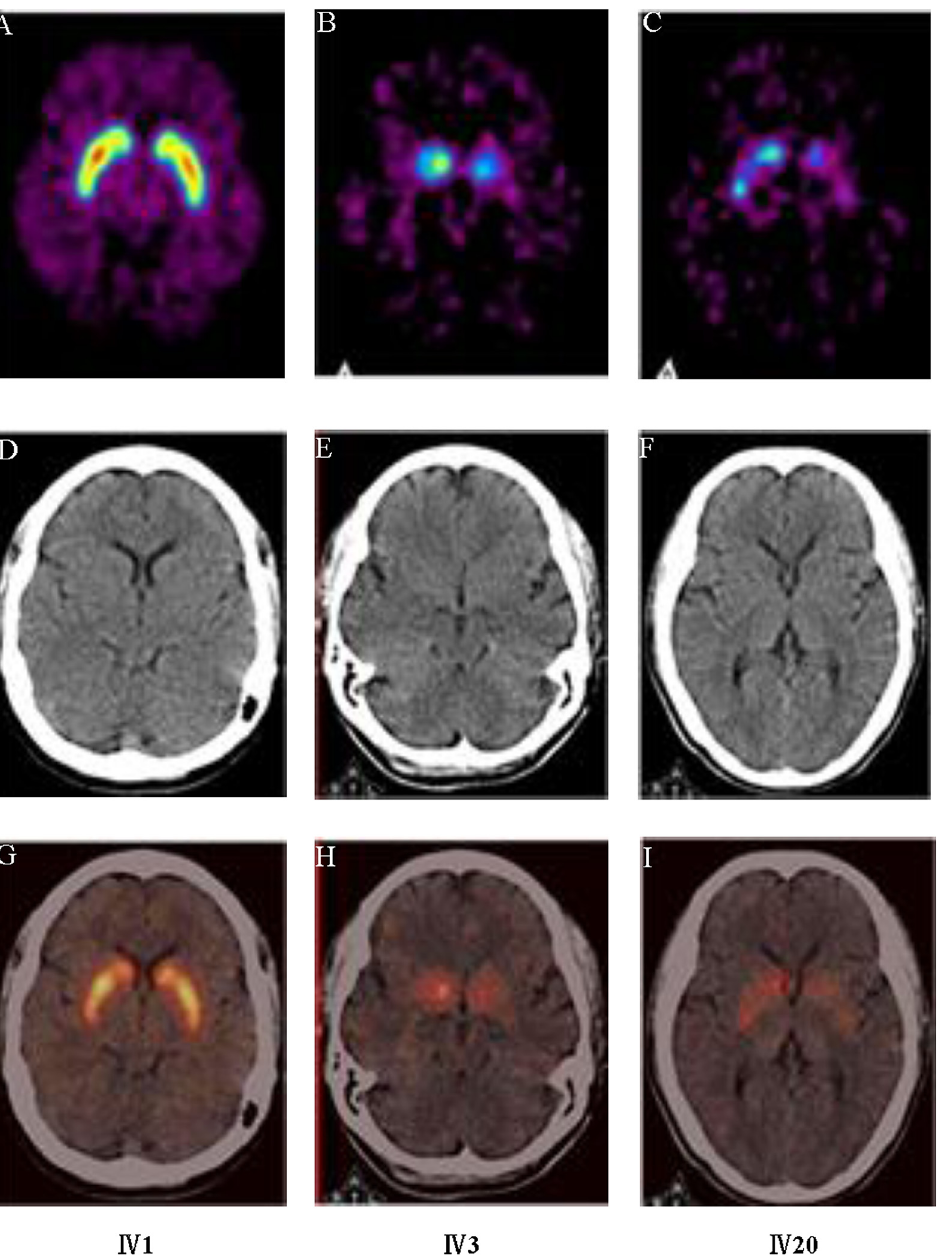
Fig 3. PET imaging of DATs via 11 C-CFT in pedigree with p.N279K MAPT mutation. A-C: Axial positron emission tomographic images of 11 C-CFT uptake in three family members, A, Ⅳ -1, B, Ⅳ -3, C, Ⅳ -20; D-F: The transverse CT in three family members, D, Ⅳ -1, E, Ⅳ -3, F, Ⅳ -20; G-I: Integrated imaging of Axial positron emission tomographic images and transverse CT in three family members, G, Ⅳ -1, H, Ⅳ -3, I, Ⅳ -20. The region with the highest signal intensity indicates the intake of 11 C-CFT by regional dopamine transporter.